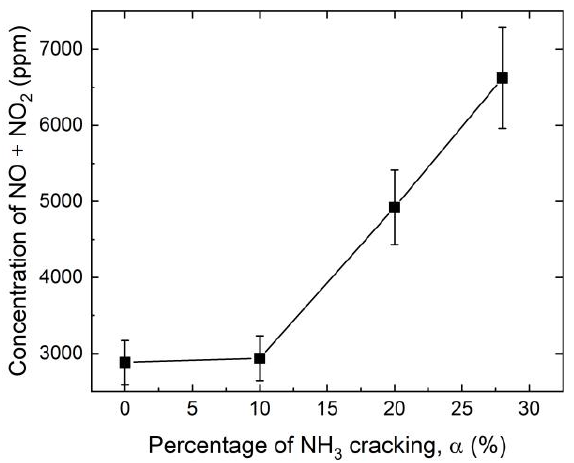
Figure 6. Concentration of NOx (i.e., NO + NO 2 ) as a function of ammonia cracking. For all flames, the equivalence ratio was 0.95, and the bulk flow velocity was 7 m/s.